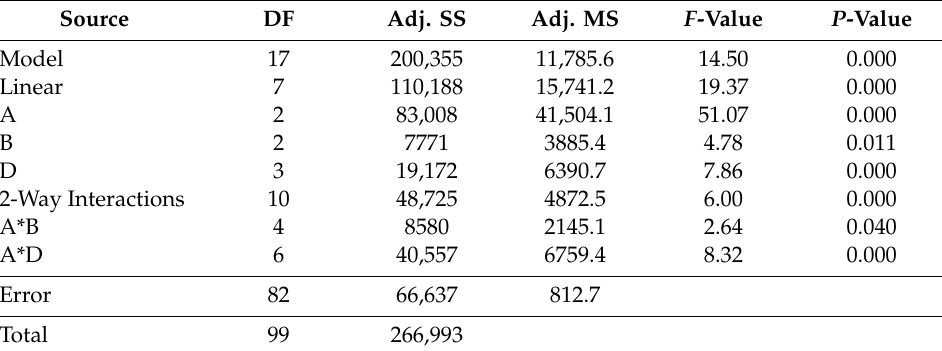
Table 10. Analysis of variance for principal stress (four locking screws).